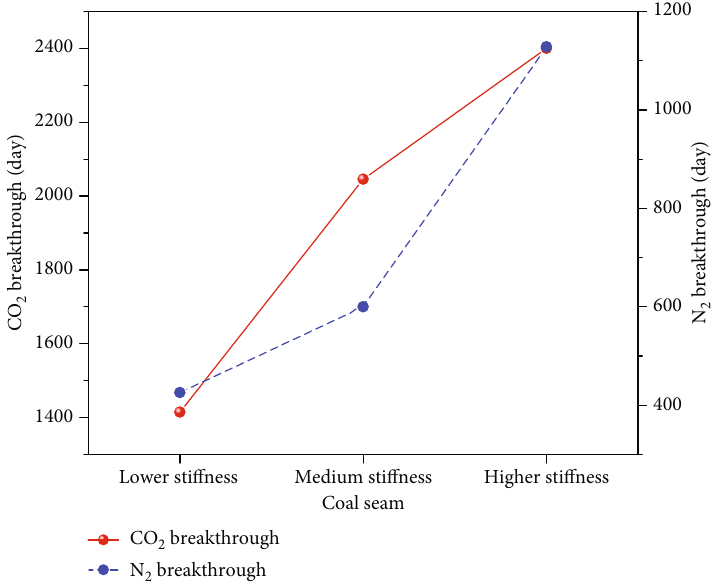
/N partial pressure evolution. (a) CO 2 2